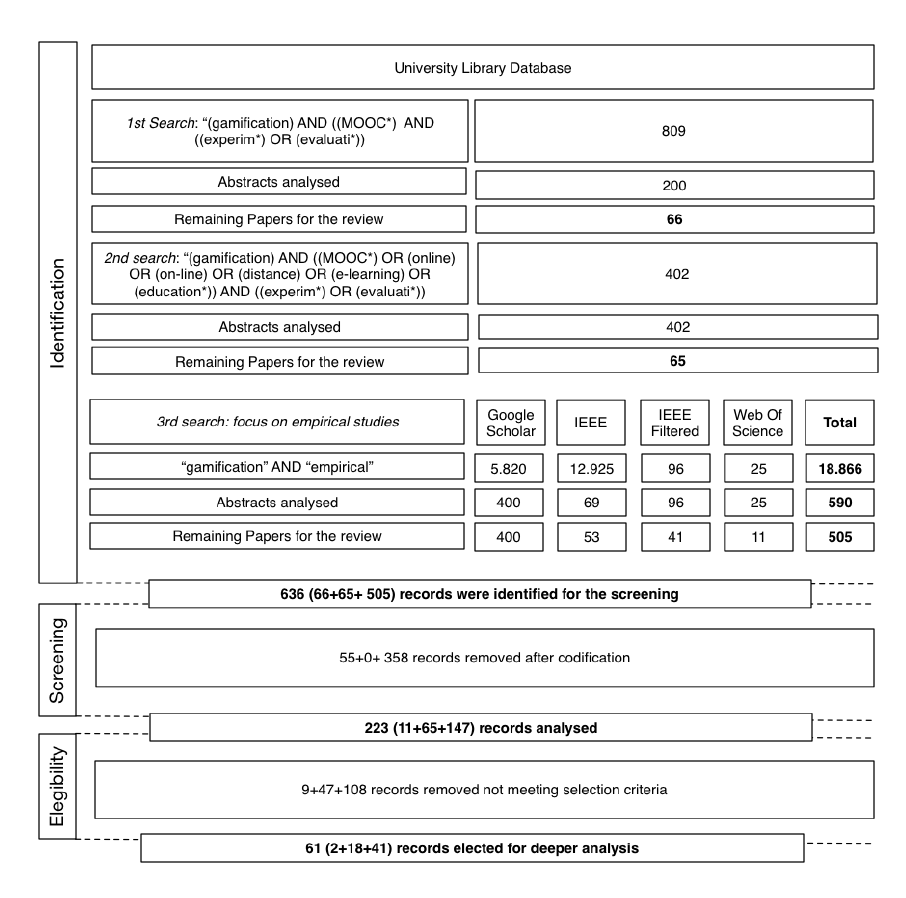
Figure 1. Flow chart of the systematic literature review process according to PRISMA. Table 1. Criteria for paper selection (steps two to five of the five steps of the systematic literature review performed, omitting the keyword